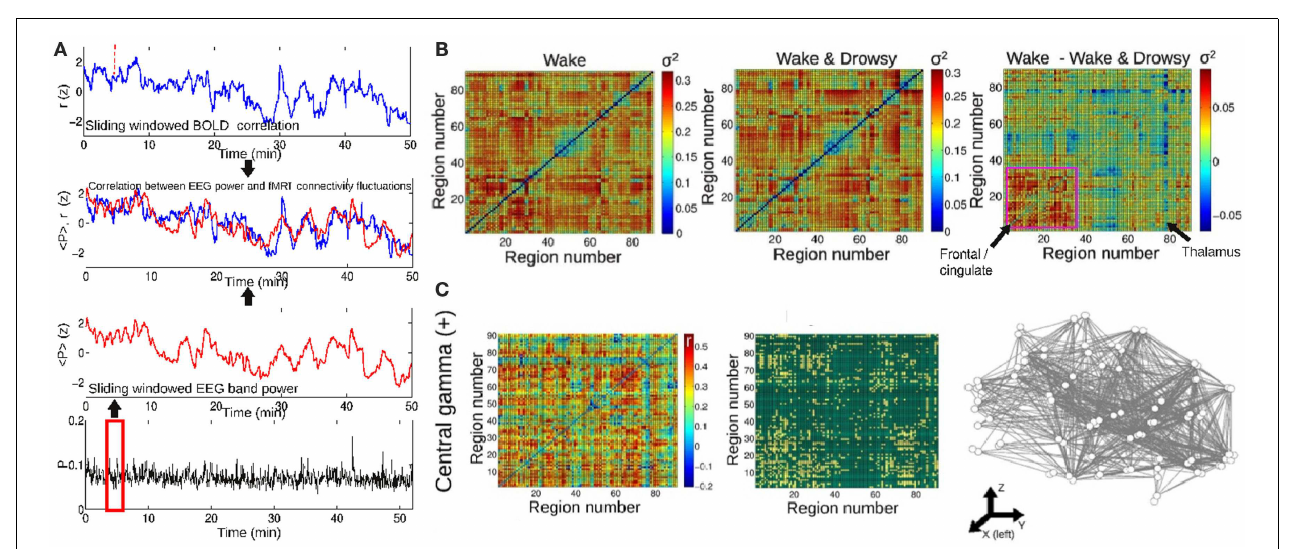
of EEG power in different frequency bands. (B) The temporal variance ( σ 2 ) of functional connectivity fluctuations between all pairs of regions. Results are for awake subjects and for subjects undergoing transitions to light sleep (drowsiness). On the right, the difference between both conditions is plotted. (C) Pairs of regions showing a positive correlation between BOLD functional connectivity and central EEG power in the gamma band (30–60Hz). Figure adapted fromTagliazucchi et al. (2012b).